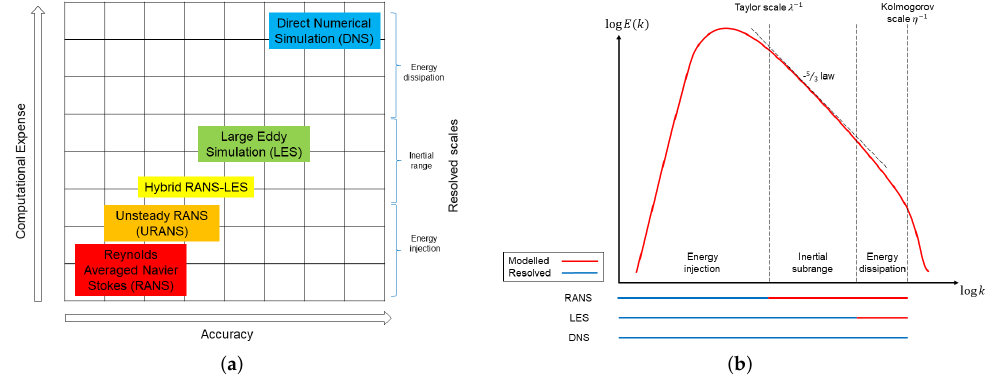
Figure 1. Comparison of the different approaches for modelling turbulence: ( a ) Computational expense against accuracy for each approach; ( b ) the correlation of each method to the energy spectrum, highlighting which portion of the spectrum is resolved or modelled in each